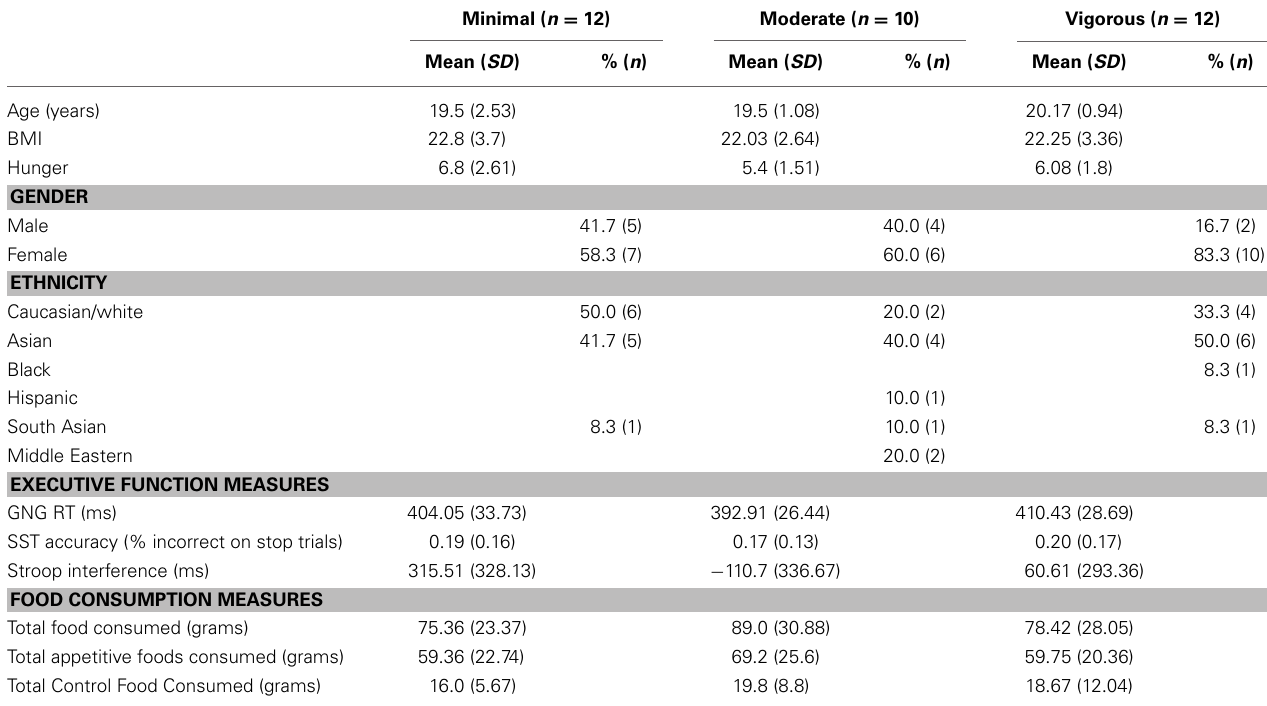
Table 1 | Participant demographic, EF task performance, and food consumption by exercise